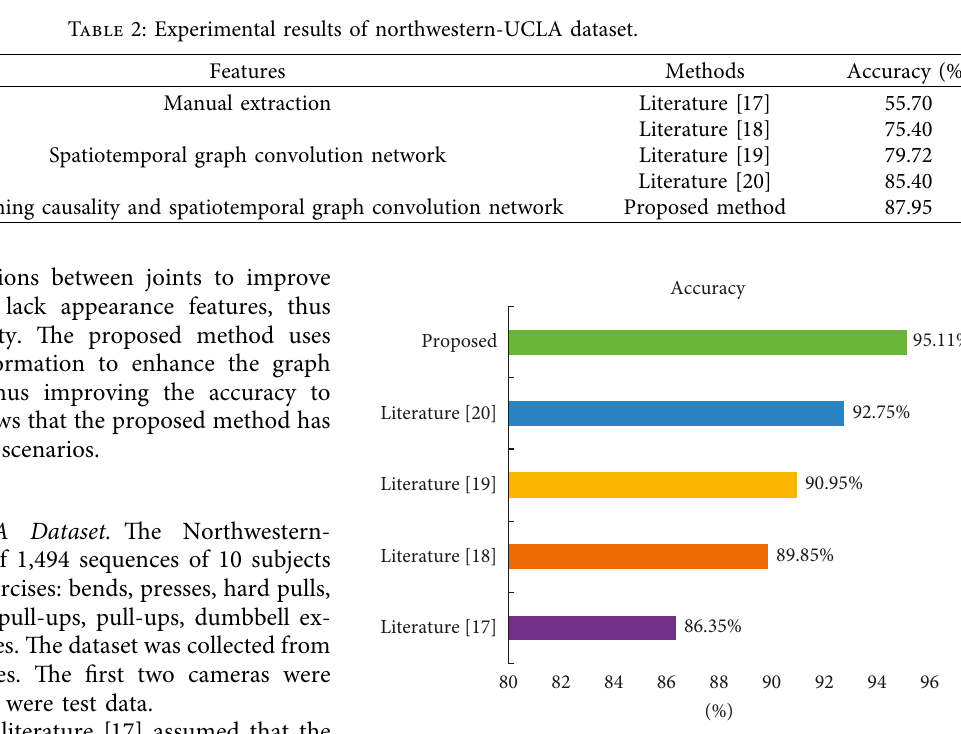
Figure 8: Experimental results of SBU interaction dataset.